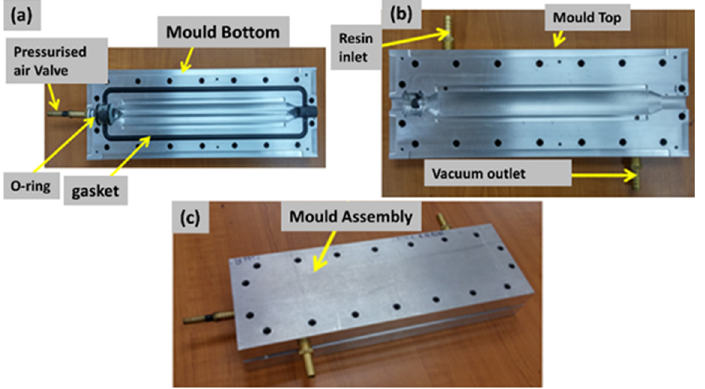
Figure 3. Mold design for manufacturing a tubular section ( a ) bottom mould ( b ) top mould ( c ) mould assembly.